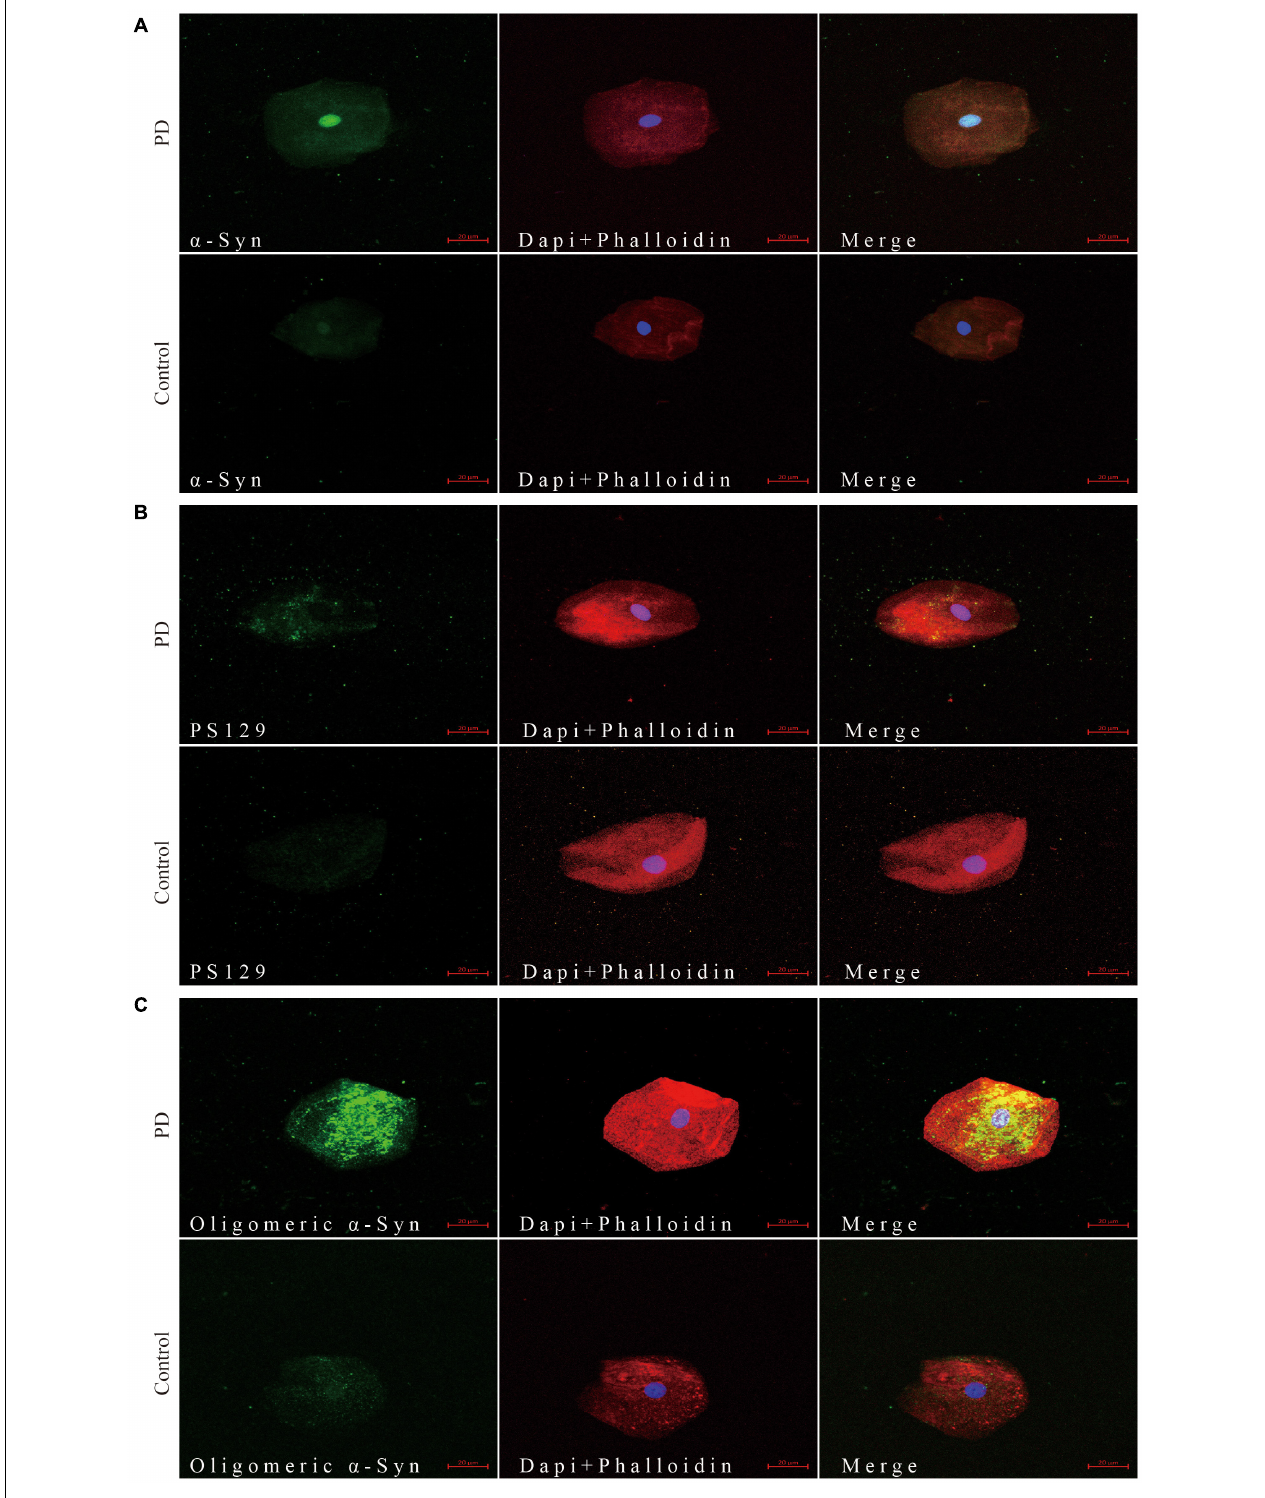
FIGURE 1 | Confocal microscopy ( × 40) study of α -Syn (A) , pS129 (B) , and oligomeric α -Syn (C) expression pattern in oral mucosa cells of PD patients and controls. The first column shows α -Syn (A) , pS129 (B) , and oligomeric α -Syn (C) distribution in green. The cytoskeleton stained with phalloidin (red) and nuclear stained with DAPI (blue) are shown in second column. Merge images are shown in third column. Scale bar: 20 µ m. PD, Parkinson’s Disease; α -Syn, α -synuclein; pS129, phosphorylated α -Syn at Ser129.